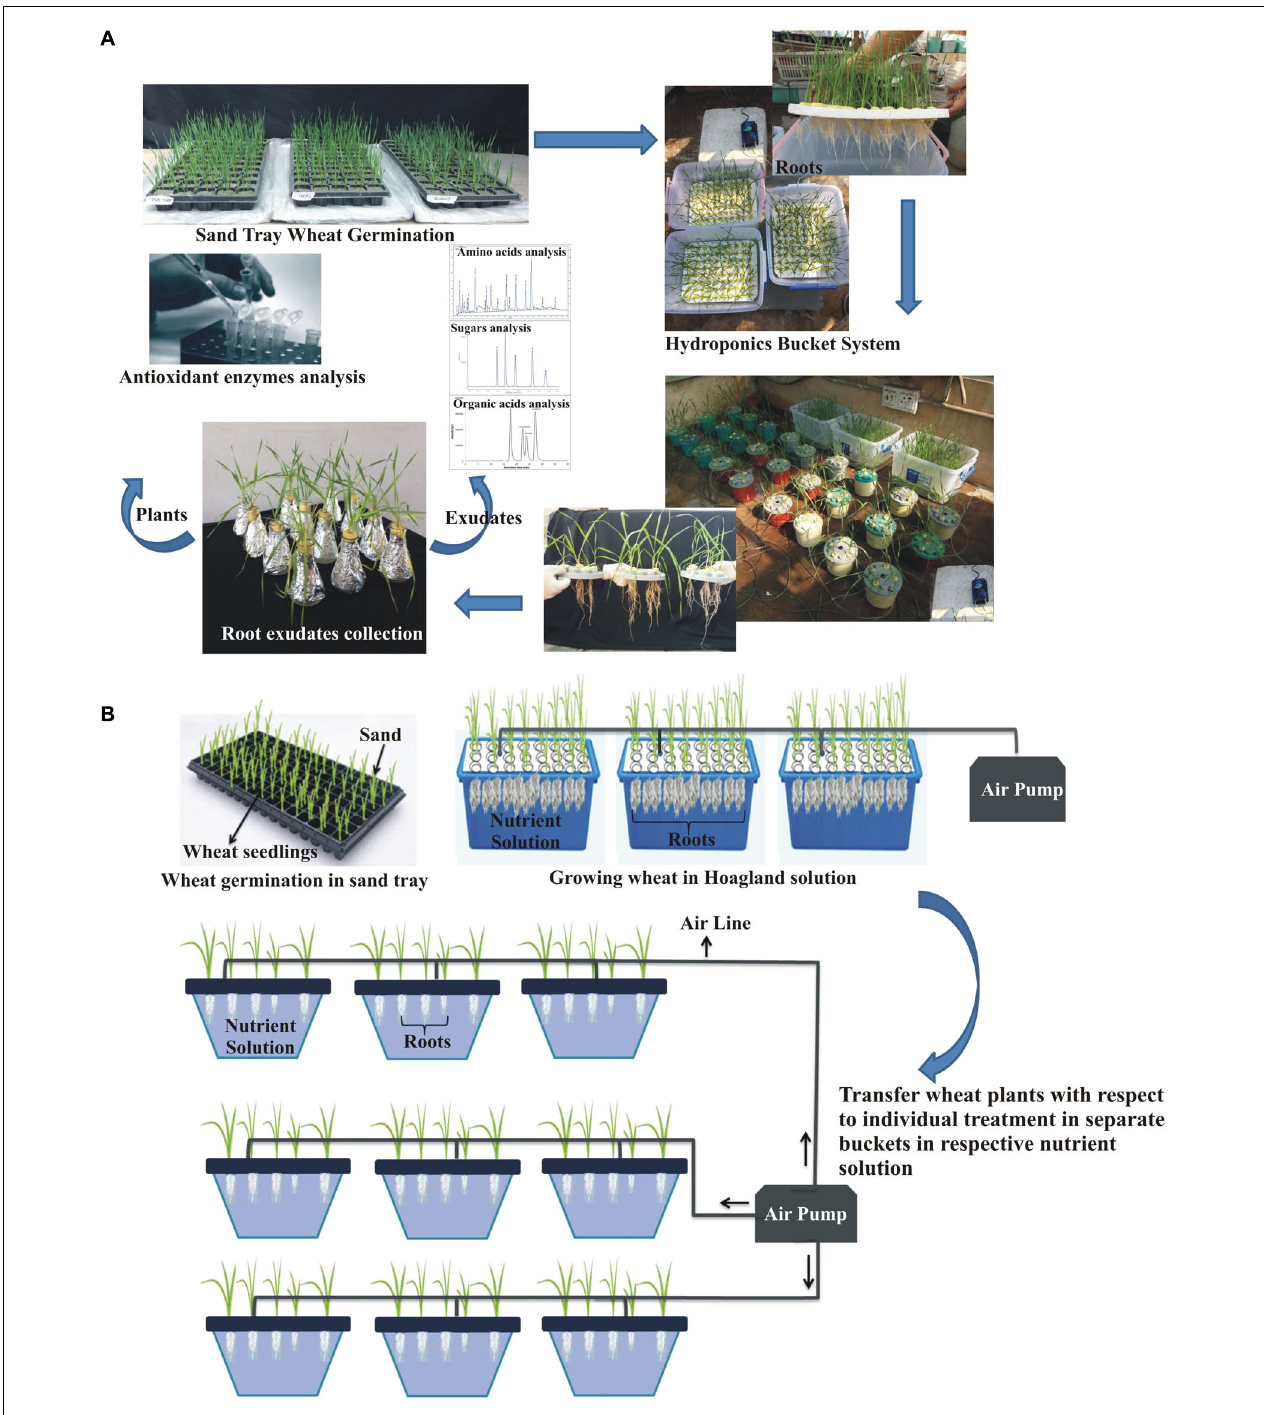
FIGURE 1 | Illustration of the standing-aerated hydroponic growing system consisting of experimental setup for root exudates collection and analysis (A) . Demonstration of sterilized hydroponic system; each treatment was aerated individually (B) .